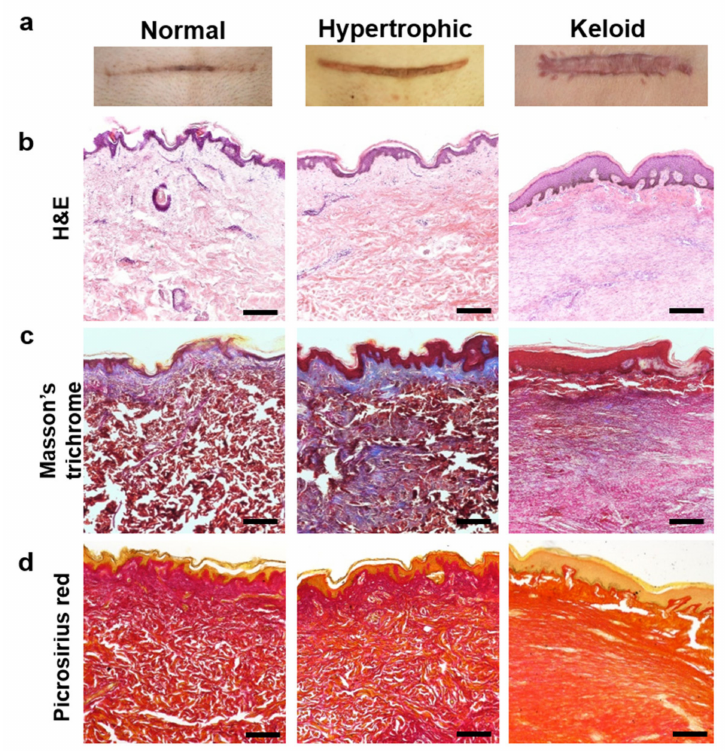
Figure 1. Histologic evaluation of skin tissues from patients with NHK scars. ( a ) Representative gross images of patient scar tissues. ( b ) Hematoxylin and eosin (H&E)-stained scar tissues for nuclei (purple) and deposited extracellular matrix (ECM, pink). ( c ) Masson’s trichrome-stained scar tissues for collagen deposition (blue) and cytoplasm (pink). ( d ) Picrosirius red-stained scar tissues for collagen deposition (red) and cytoplasm (orange). Scale bar = 200 µ